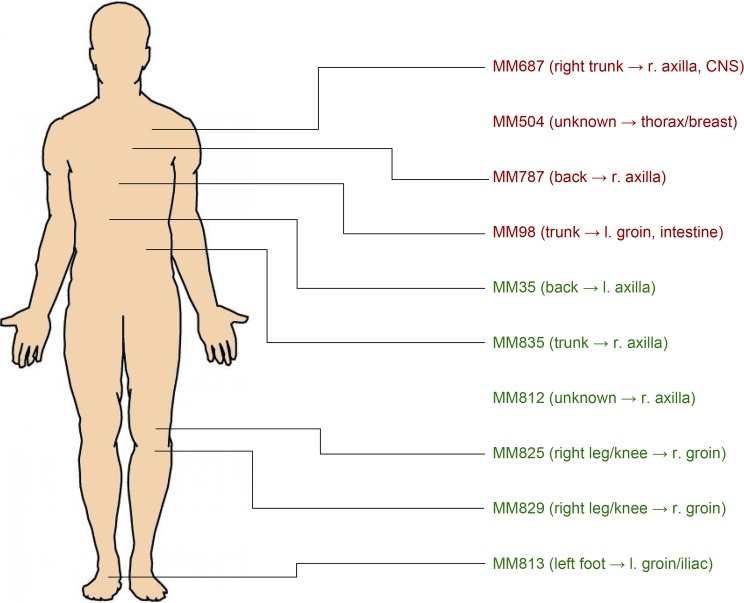
Location of primary tumors on the body of melanoma patients and their route of progression.Red font represents poor prognosis (“non-survivors”), green font represents good prognosis (“survivors”).